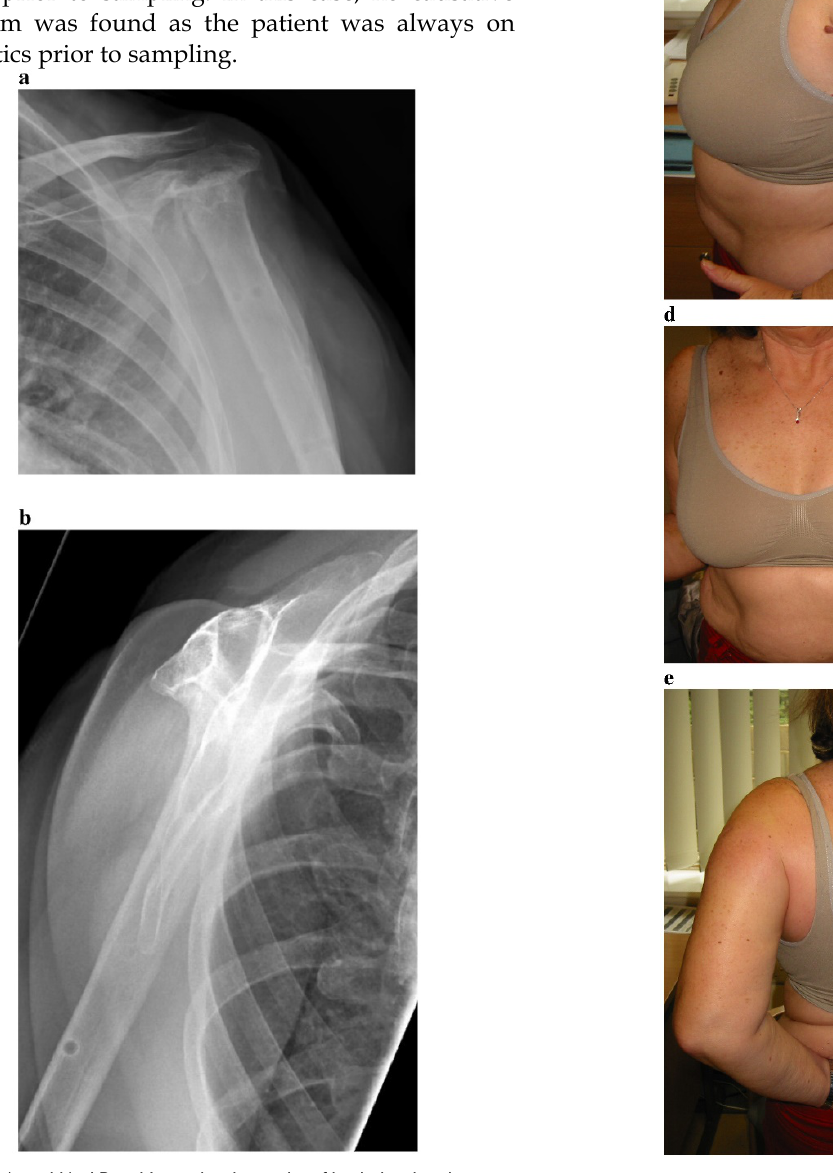
Figure 6 . (a and b). AP and Lateral radiographs of healed arthrodesis. Figure 7 . (a to e). Functional range of movement out of the Ilizarov